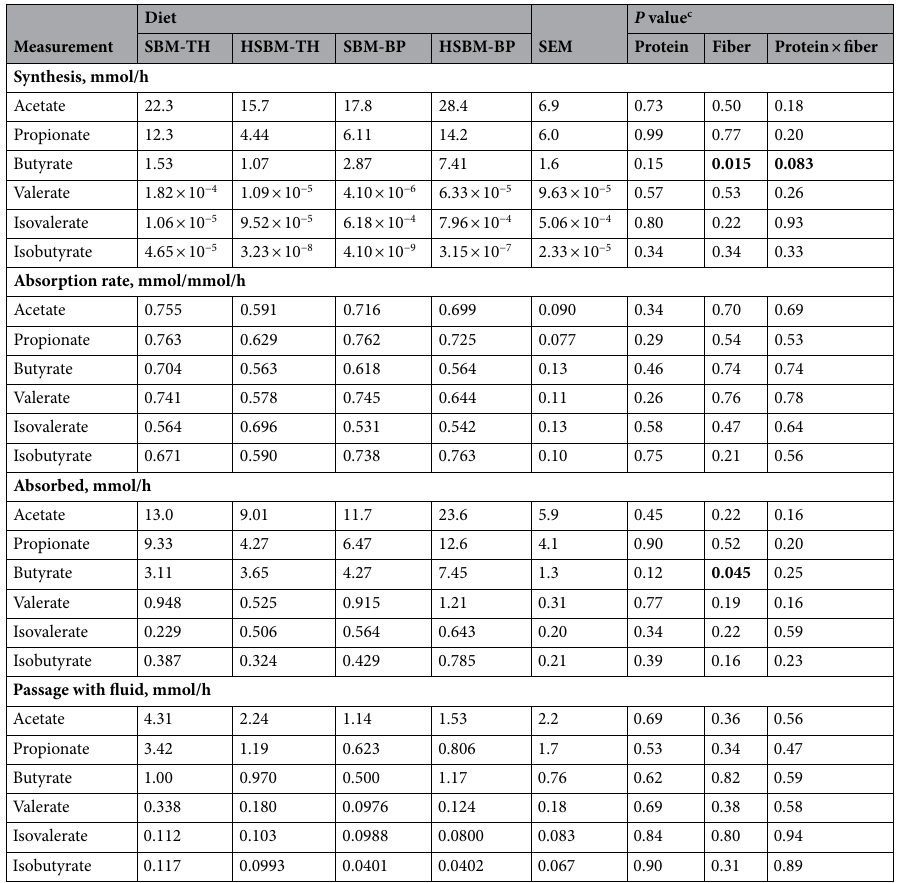
Table 4. LS means for VFA dynamics measurements as differentiated by diet along with P values for the effects of protein source, fiber source, and the interaction of protein and fiber source a,b . a HSBM-TH heat-treated soybean meal and timothy hay, SBM-TH soybean meal and timothy hay, HSBM-BP heat-treated soybean meal and beet pulp, SBM-BP heat-treated soybean meal and beet pulp. b mmol/mmol/h = fraction of carbon per hour. c Bolded values indicate significance or a